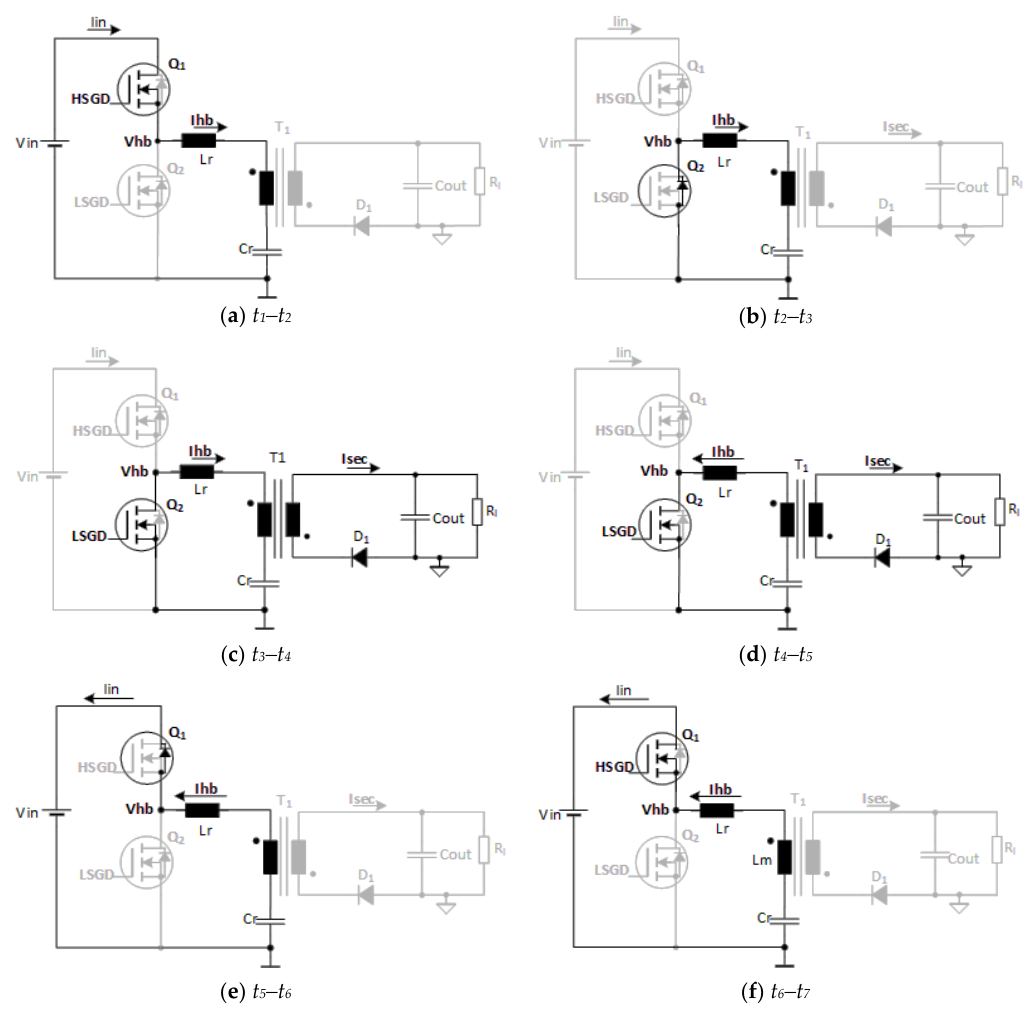
Figure 2. Asymmetric flyback converter operation phases.